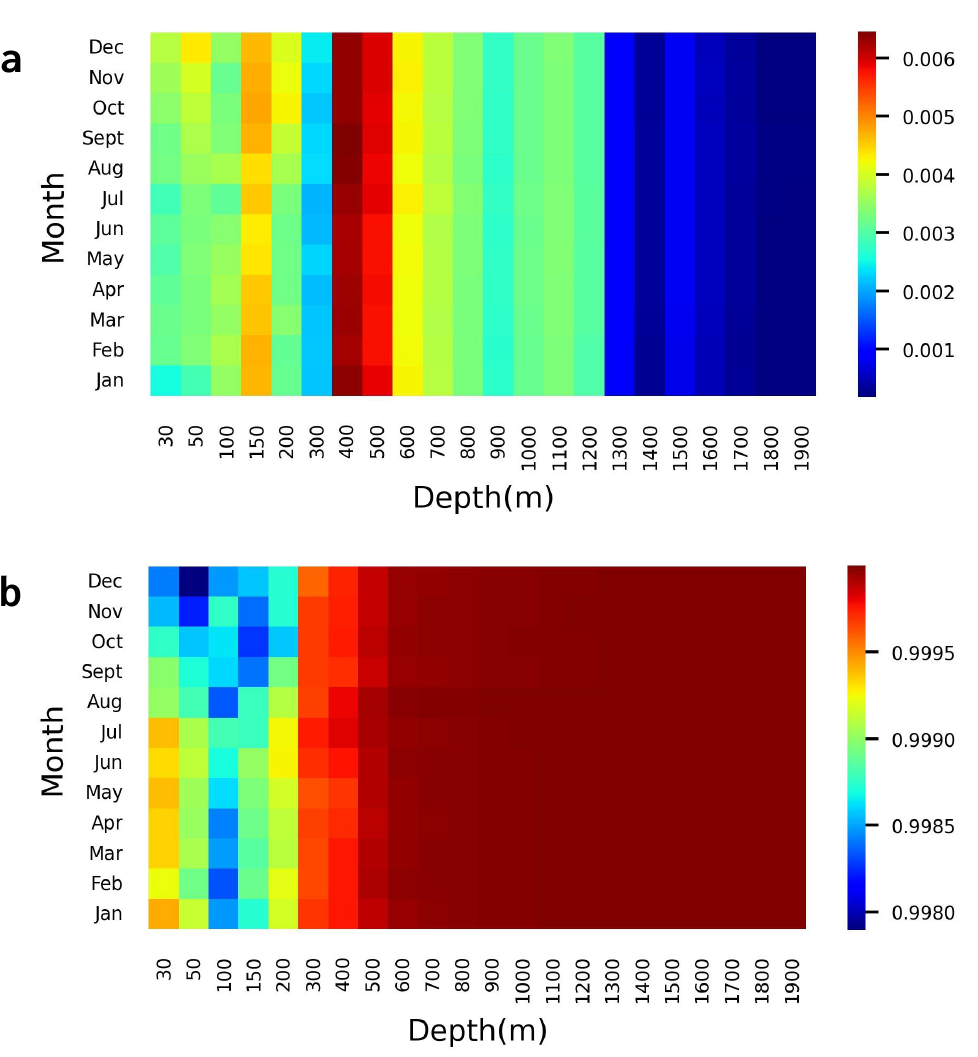
Figure 7. Model performance for SS estimation. ( a ) Normalized root mean square error ( NRMSE ), ( b ) coefficient of correlation ( R ) of the SS estimation at each depth level and in each month of